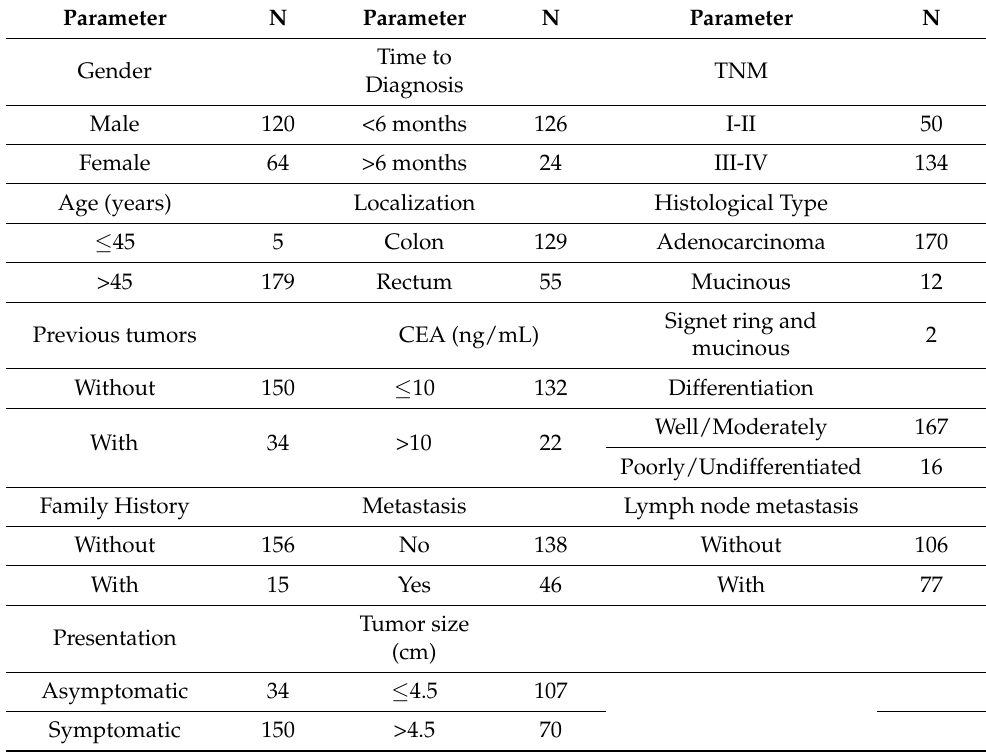
Table 1. Demographic and baseline characteristics of the